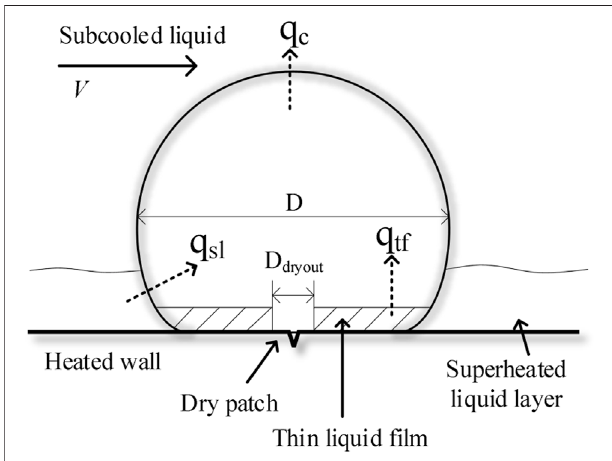
FIGURE 2 | Heat fl ux partition for a growing bubble in the subcooled boiling fl